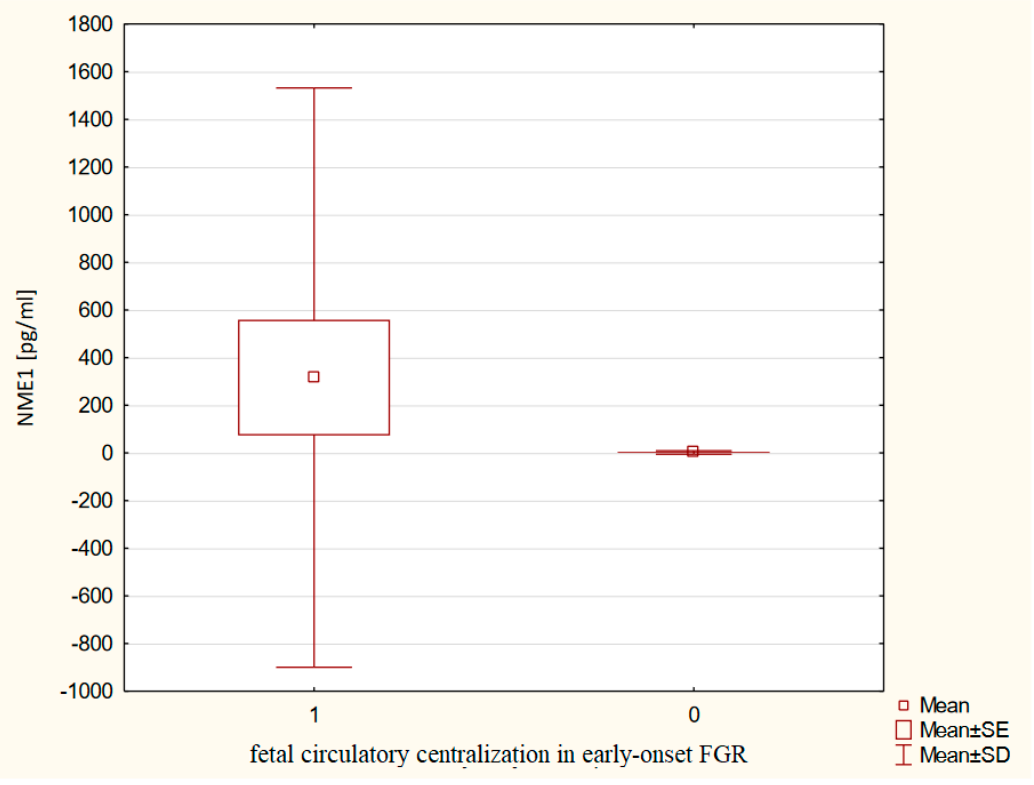
Figure 2. The maternal serum NME1 concentrations in relation to fetal circulatory centralization in the early-onset FGR.